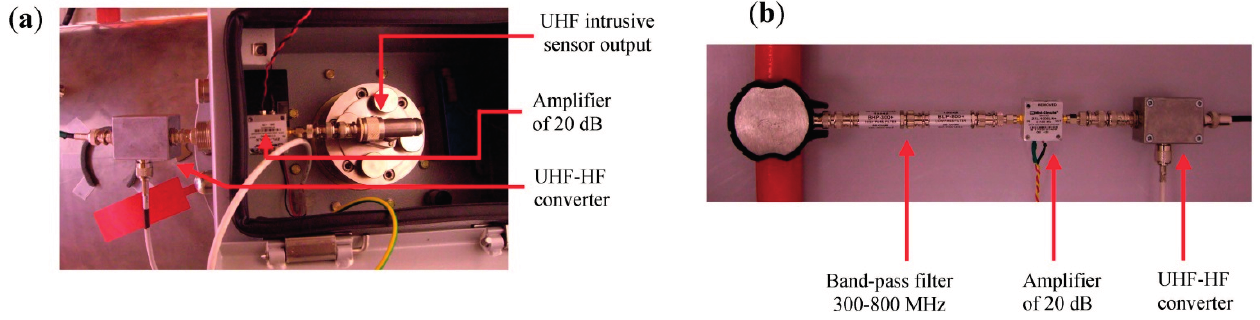
Figure 9. ( a ) Outside view of the UHF invasive sensor with amplifier and UHF-HF converter; ( b ) Non-invasive sensor with band-pass filter, amplifier and